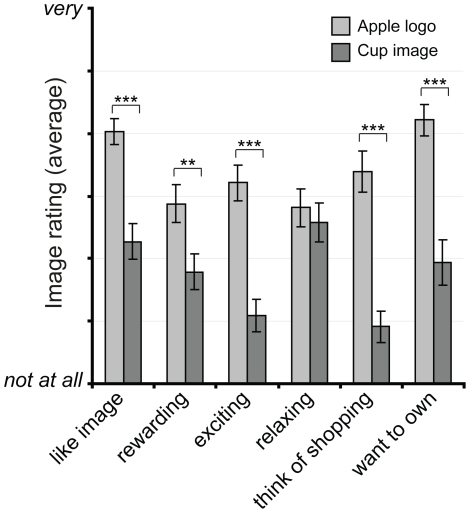
Evaluation of prime.An independent sample of 33 subjects (10 female; M
Age = 22.4; range: 20–25) were presented with images of the Apple logo and the cup as used in the fMRI study. They rated several statements about the images from 1 (Not at all) to 7 (Very). Like = “How much do you like this image?”; Rewarding = “How rewarding do you find the image above?”; Exciting = “How exciting do you find the image above?”; Relaxing = “How relaxing do you find this image?”; Shopping = “Does the image above make you think of shopping?”; Like = “How much would you like an Apple product/the cup?”. Displayed are average responses and standard errors.